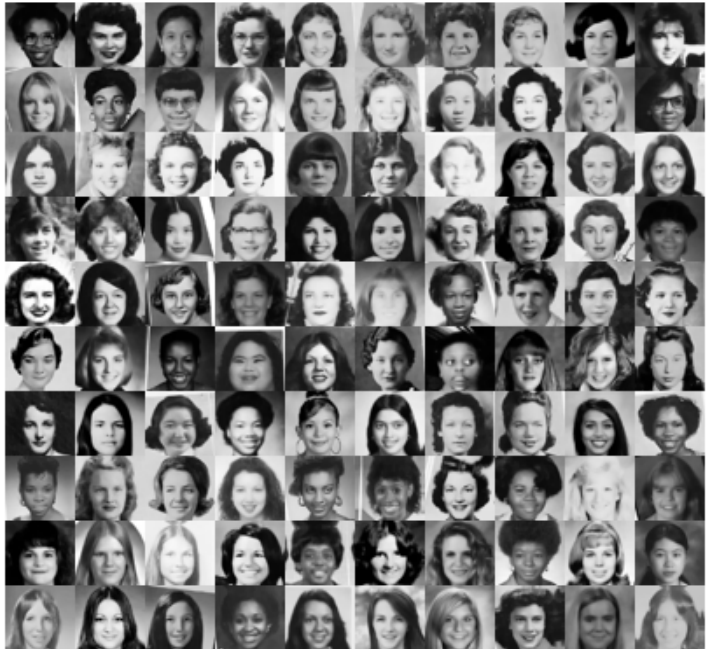
Figure 3. A random subset of 100 images taken from the yearbook